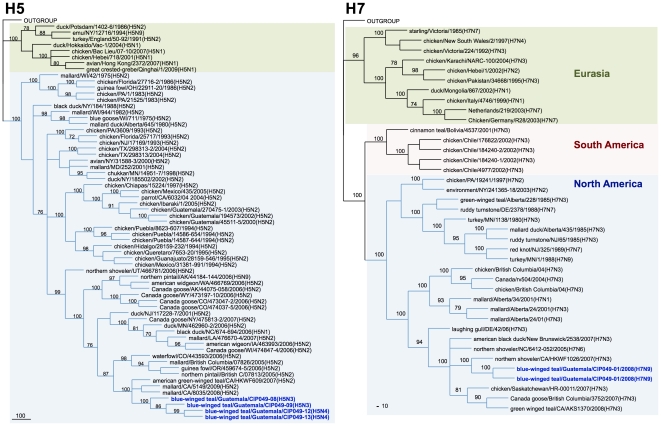
Phylogenetic trees for H5 and H7 HA genes.Trees were generated in PAUP 4.0b10 using the Neighbor-Joining method with 1000 bootstrap replicates (bootstrap values above 70% are shown). Scale bar on the bottom-left indicates number of nucleotide substitutions per site.